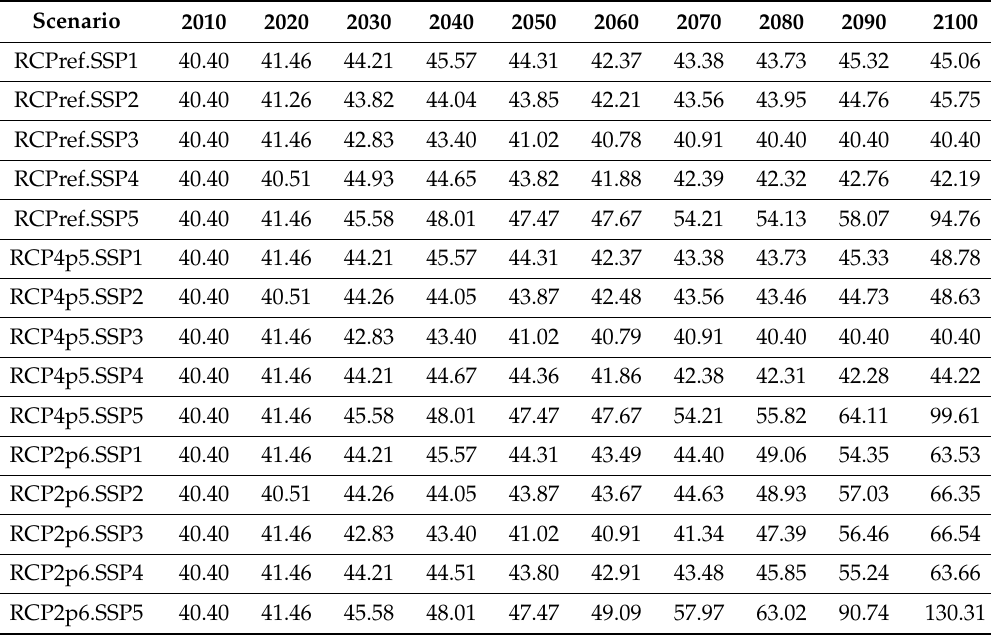
Table A19. Prices—Pulpwood (National average price per m 3 , in USD (exchange rate in 2010)).